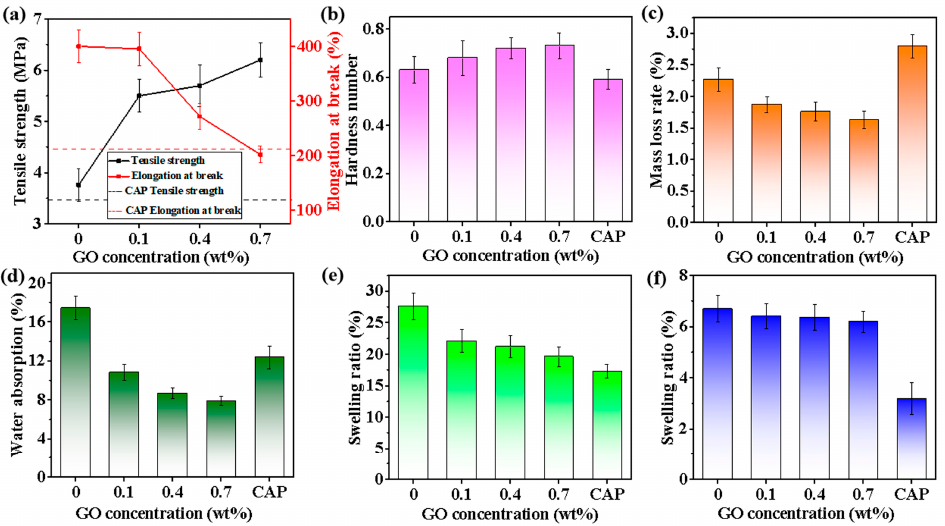
Figure 5. Physical performance tests of coating and coatings: ( a ) Tensile strength and elongation at break, ( b ) pendulum hardness, ( c ) abrasion durability, and ( d ) water absorption rate of coating film; swelling rate of ( e ) ethanol and ( f ) NaOH absorption by coating film.